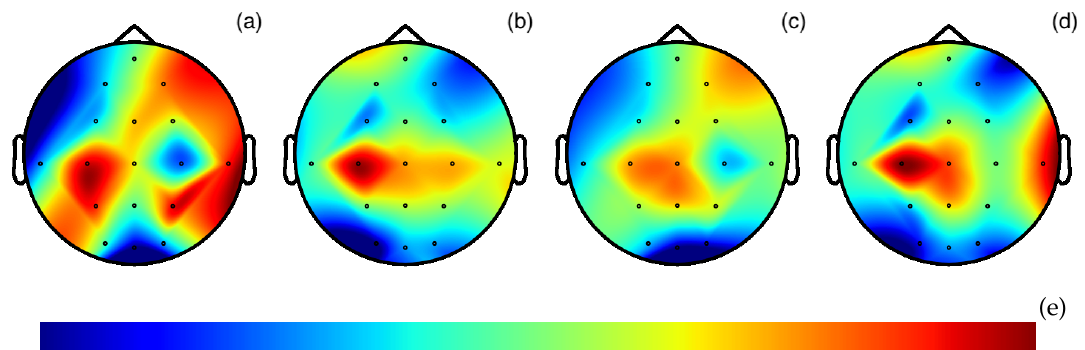
Figure 6. Topographic maps for the first 0.5 s of the four different categories. Each topographic map was generated from one subject. ( a ) HKT process owner. ( b ) Hoshin Kanri TREE (HKT) leader. ( c ) Balanced Scorecard (BSC) process owner. ( d ) BSC leader. ( e ) Colormap Jet used for the topographic